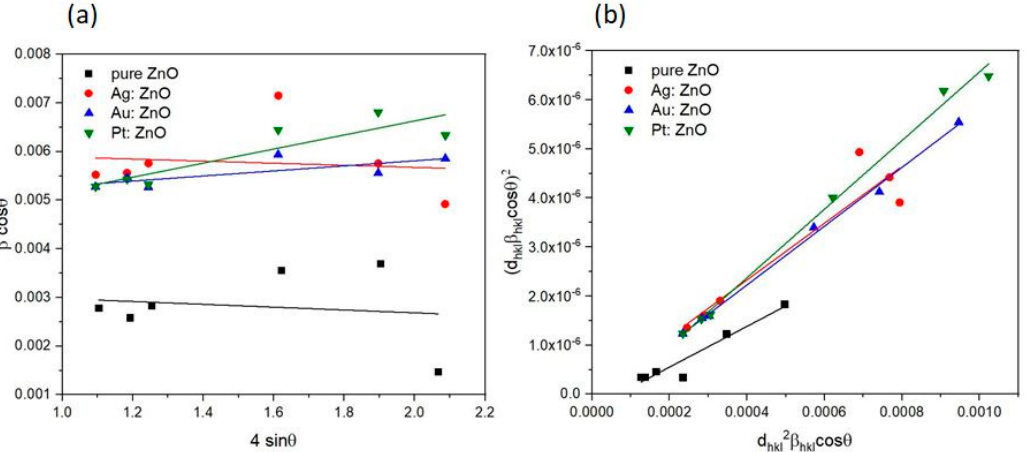
Figure 6. ( a ) Williamson-Hall and ( b ) size-strain analysis of pure and doped ZnO NPs. Using linear fit to the data, the crystallite size and strain are extracted and presented in Table 3.